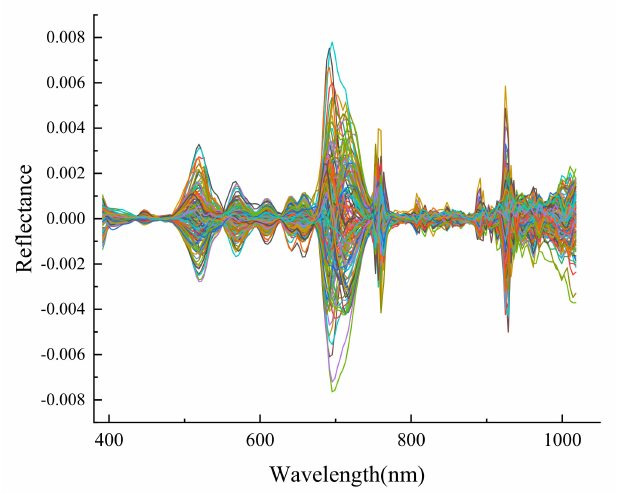
Figure 11. 1st derivative-mean centered